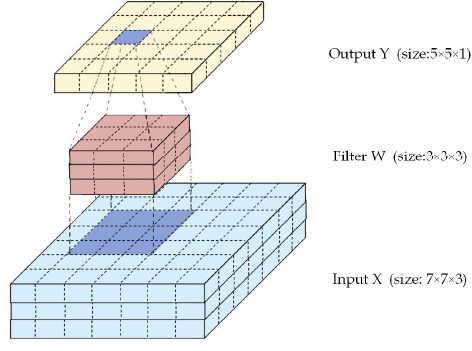
Figure 2. Illustration of convolutional layer.